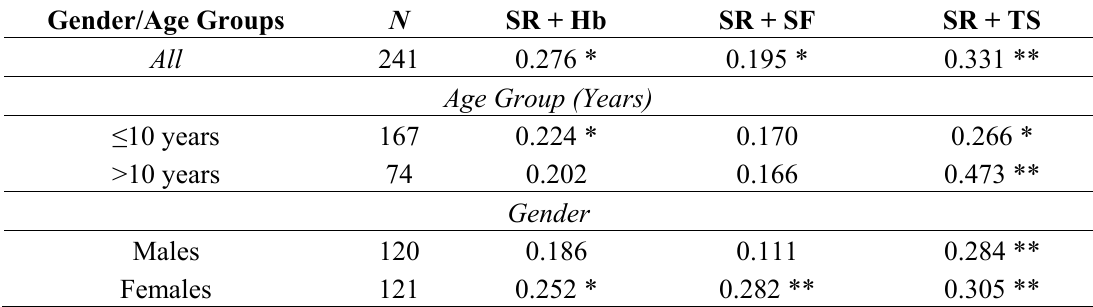
Table 2. Correlation between serum retinol and iron status indices at baseline according to age and gender. SR, serum retinol; Hb, haemoglobin; SF, serum ferritin; TS, transferrin saturation.